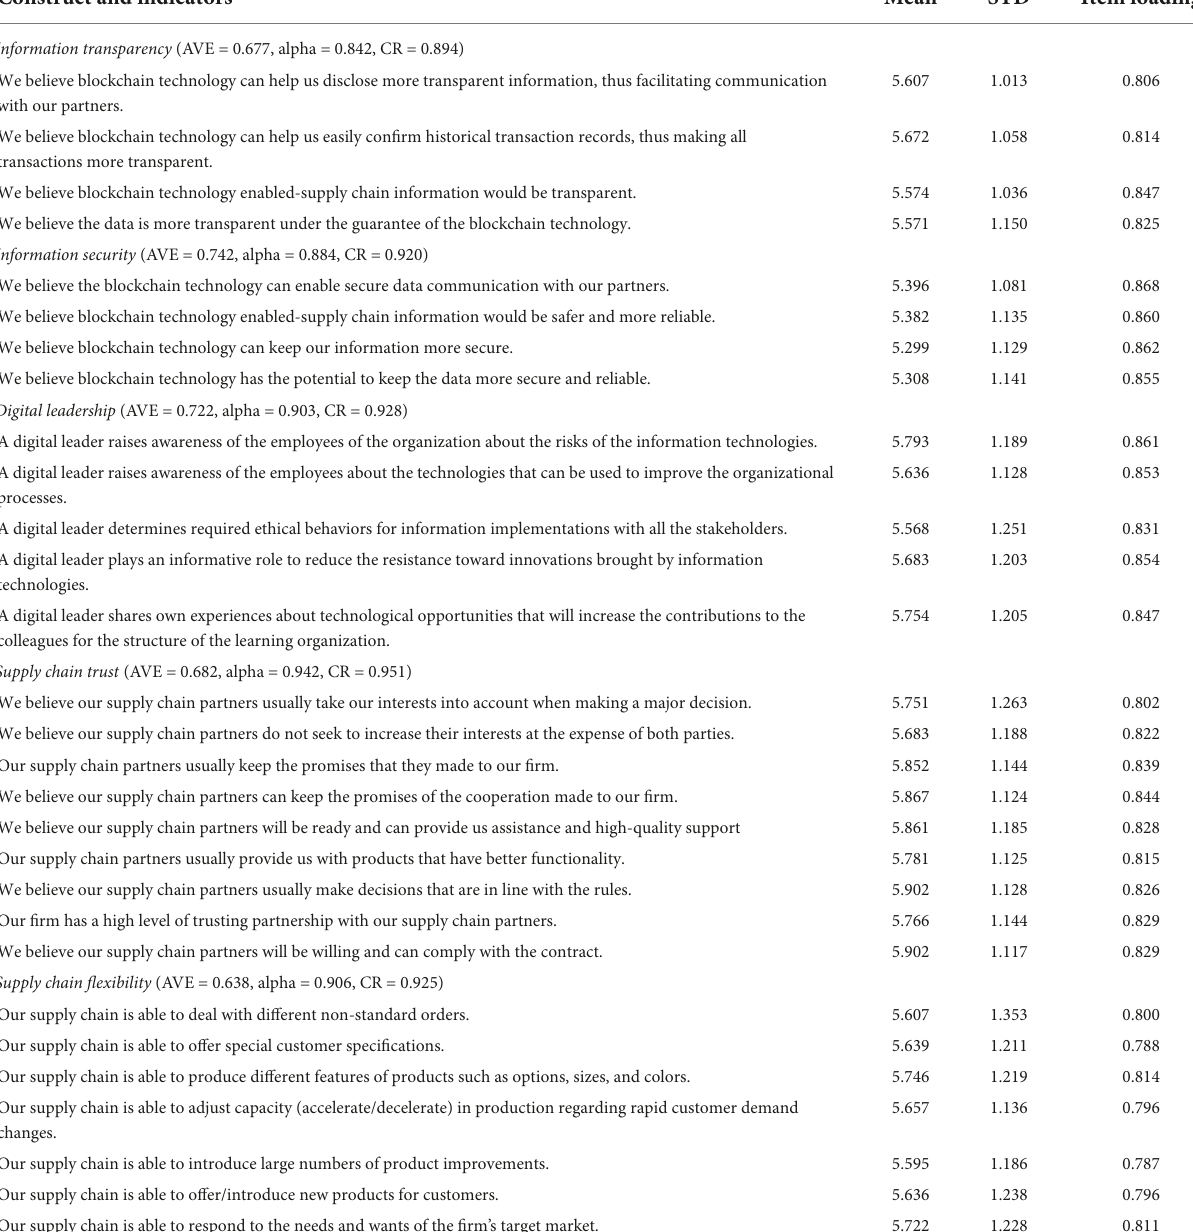
TABLE 1 Results of construct reliability and validity assessments. Construct and indicators Mean STD Item